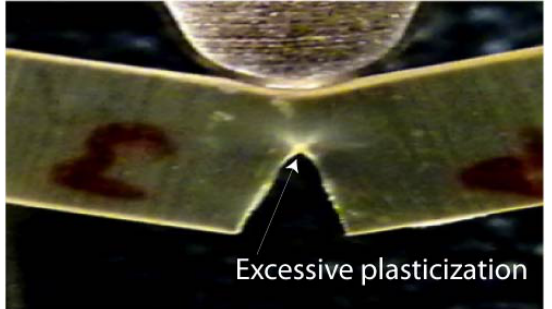
Figure 4. Ductile failure of 8 wt.% POSS–epoxy